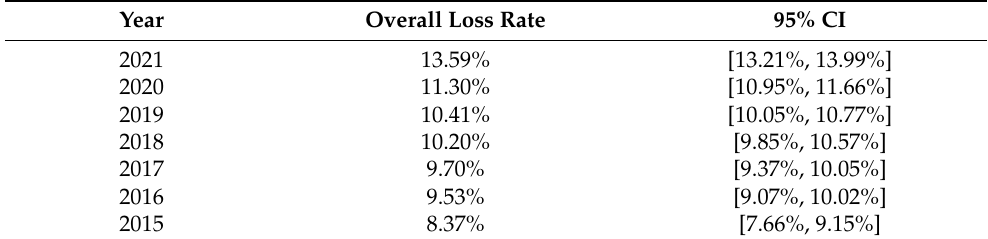
Table 2. Overall colony loss rates reported at the national-level in the New Zealand Colony Loss Survey between the years 2015 and